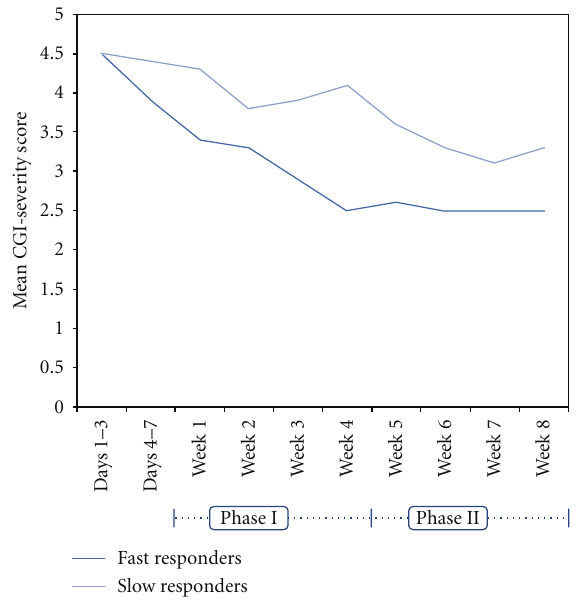
Figure 4: Comparison of the mean clinical global impression severity (CGI-S) scores for fast and slow responders during phase I (weeks 1–4) and phase II (weeks 4–8) of the study.